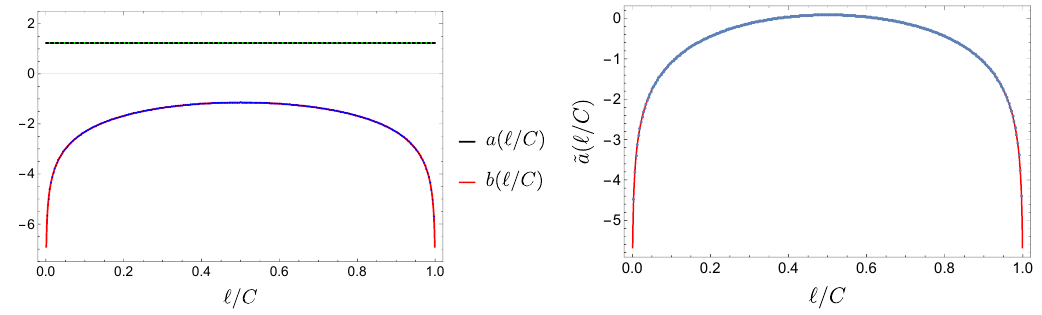
Figure 23 . Finite part of the complexity using the subregion-CA (left) and subregion- CV2.0 (right) using global coordinates. For subregion-CA, we expressed f ( ‘=C )